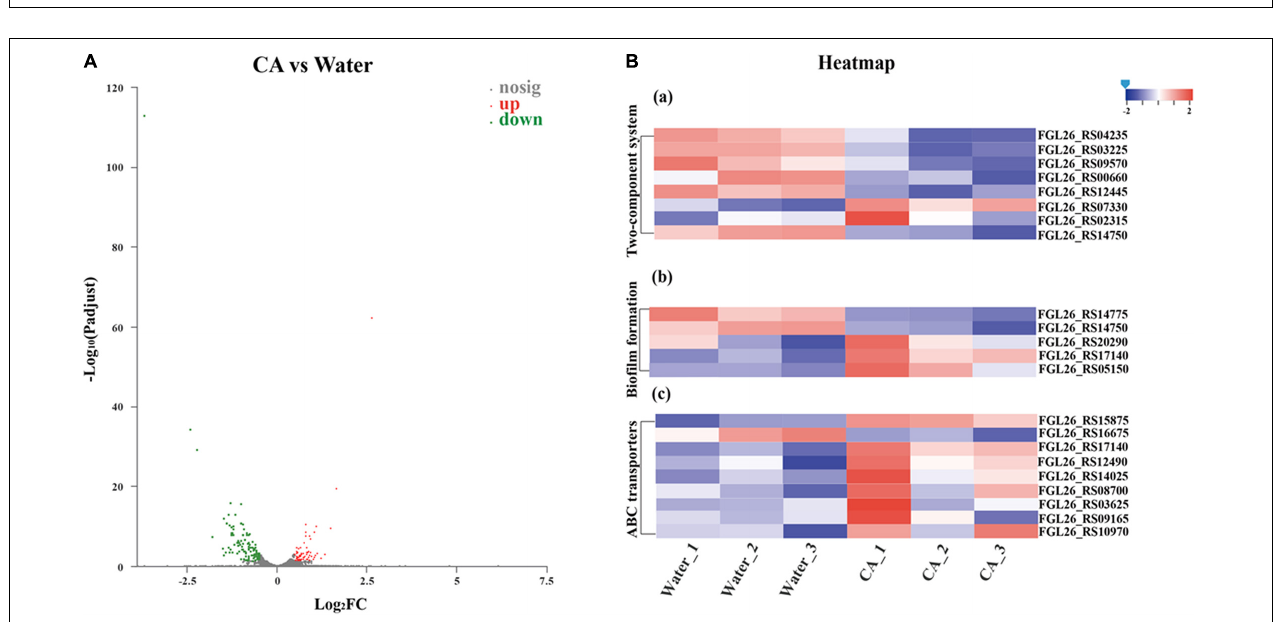
FIGURE 6 | Verification of the binding of CA to Y. enterocolitica . (A) The frequency changes during binding. (B) The weight changes during binding. (C) The fluorescence intensities of Y. enterocolitica after treatment with different concentrations of CA.